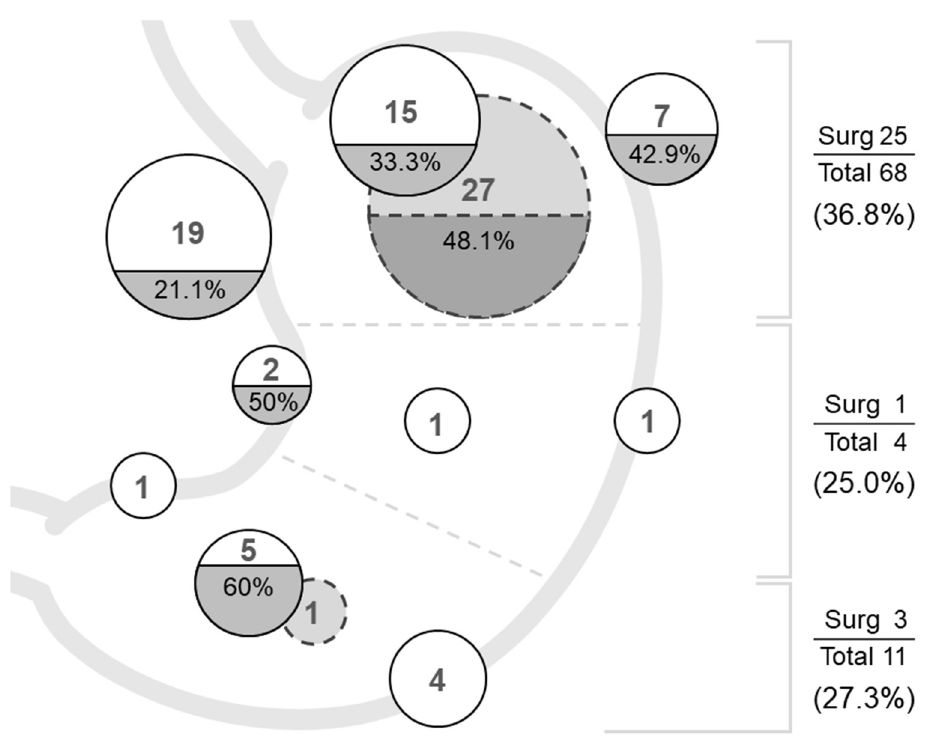
Figure 5. The location of the tumors and the percentage of the patients requiring